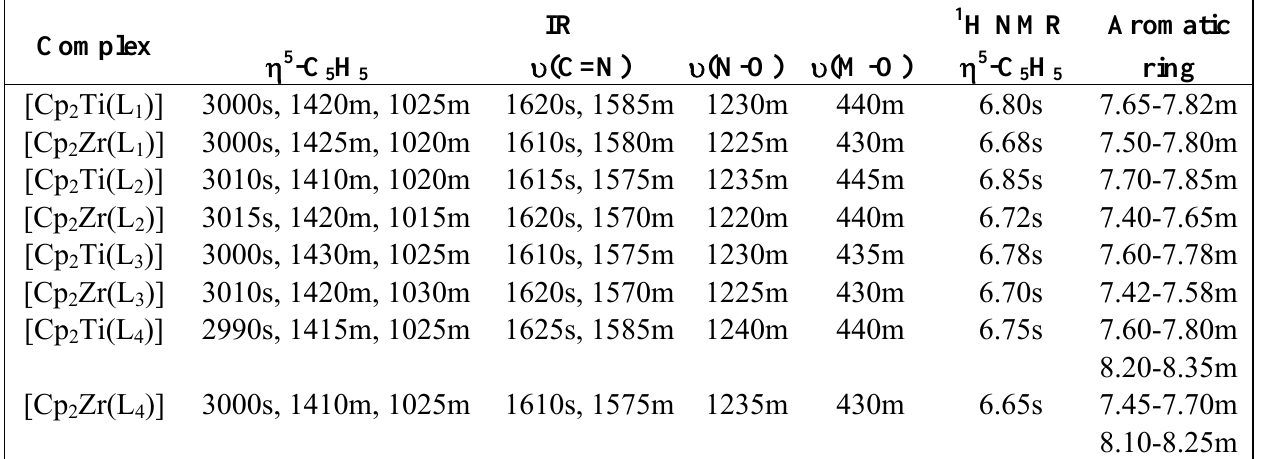
Table 2. IR (cm -1 ) and 1 H-NMR ( δ , ppm) data of titanium(IV) and zirconium(IV)